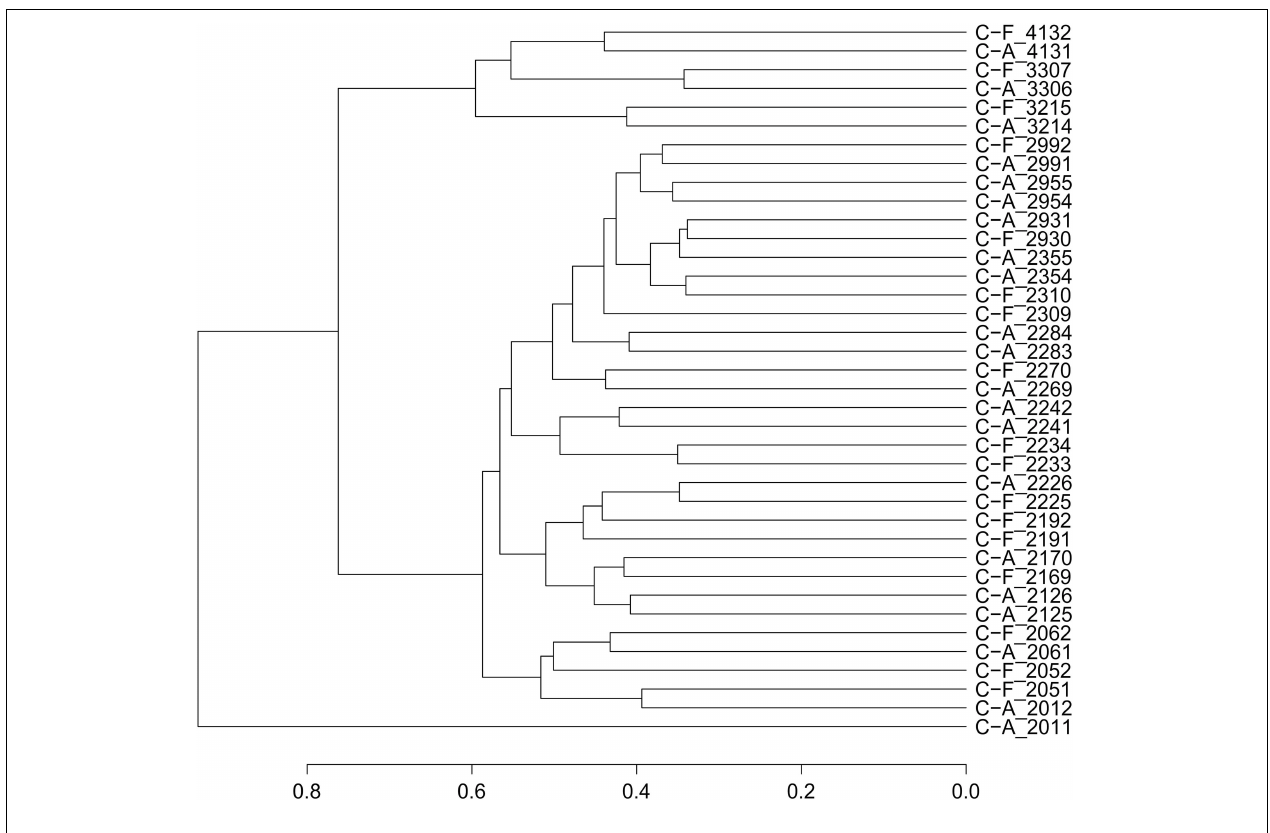
FIGURE 1 | Dendrogram of twin pairs based on RNA expression patterns.